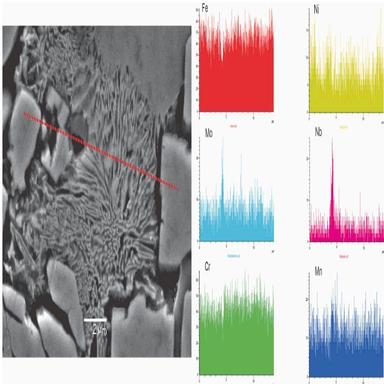
SEM-Mapping image of sample SDSS-Nb as-cast condition, Eutectoid secondary austenite and σ phase with cellular morphology (KOH 30%, 1,5V for 30 s).